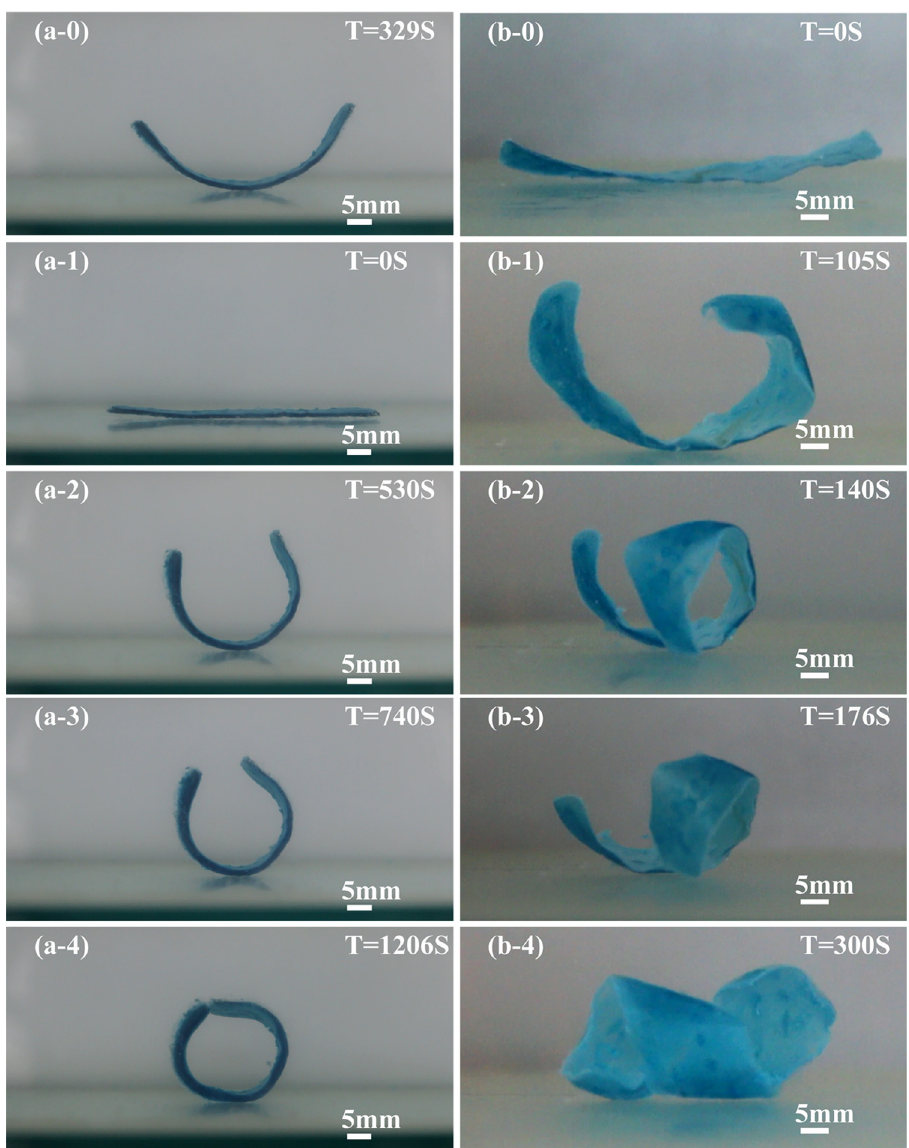
Figure 6: E ff ect of structure model of ( a - 0 ) – ( a - 4 ) 90°/0° con fi guration and ( b - 0 ) – ( b - 4 ) 45°/135° con fi guration on deformation characteristics of intelligent PDMAA